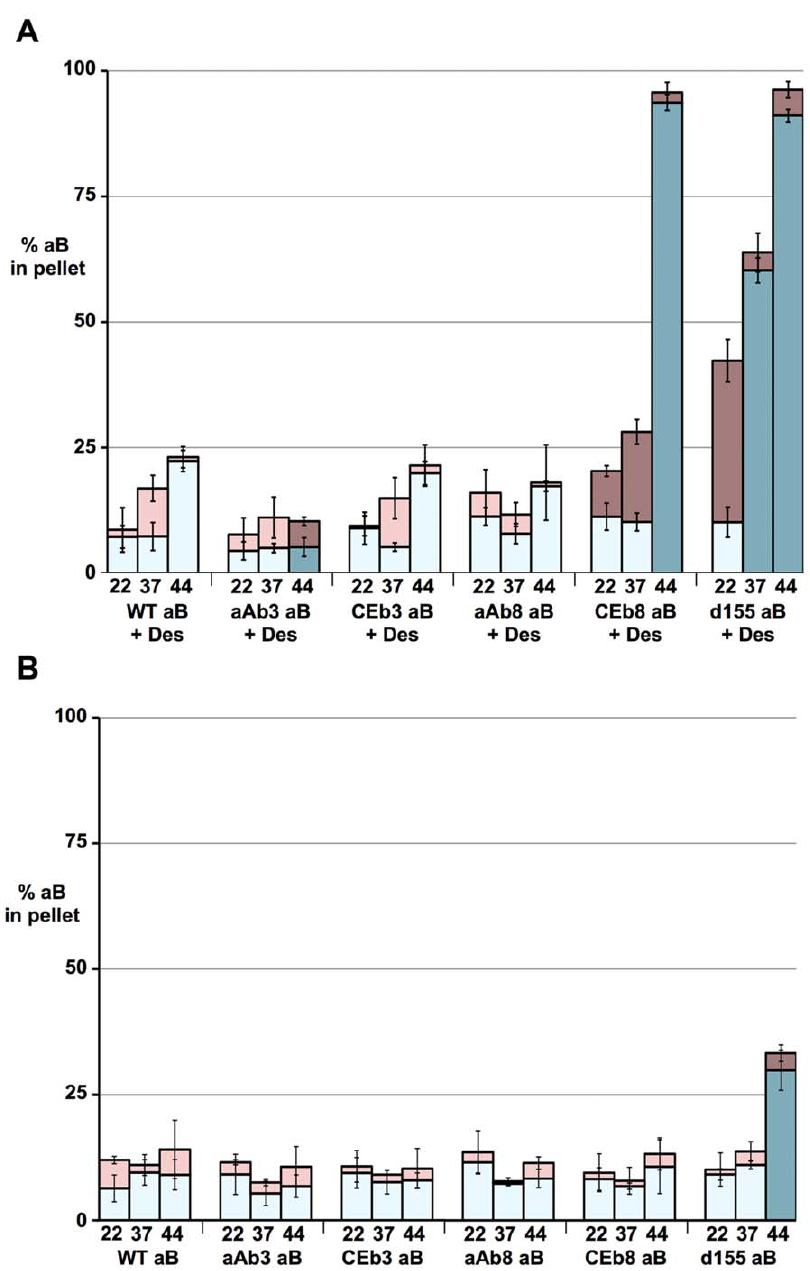
Figure 7. Cosedimentation of a B-crystallin with and without desmin filaments. A. Cosedimentation of a B-crystallin with desmin filaments. Summary of the low-speed (light blue and dark blue) and high-speed (light red and dark red) sedimentation data for various a B-crystallin protein constructs coassembled with desmin, as quantified by gel densitometry. The percentage of a B-crystallin in the pellet fractions at 22 u , 37 u and 44 u C was determined after both low- and high-speed sedimentation to quantify the association of a B-crystallin with the sedimented desmin filaments. The most striking observation is that both the CE b 8 (CEb8 aB + Des) and D 155–165 (d155 aB + Des) a B-crystallin protein constructs showed significant increases in desmin binding at 44 u C as shown by the high speed assay (44 u C, dark red bars). Conversely, a A b 3 a B-crystallin (aAb3 aB + Des) showed significantly decreased association at 44 u C at high speed. The CE b 3 (CEb3 aB) and a A b 8 (aAb8 aB) protein constructs showed similar sedimentation properties to wild type a B-crystallin. B. Aggregation of wild type and mutant a B-crystallins as measured by low- and high- speed sedimentation. Summary of the low-speed (blue) and high-speed (red) sedimentation data for the various a B-crystallin protein constructs as quantified by gel densitometry. The percentage of a B-crystallin in the pellet fractions at 22 u , 37 u and 44 u C was determined after both low- and high- speed sedimentation assay to quantify the aggregation of the a B-crystallins. All the other protein constructs showed similar sedimentation properties to the wild type (WT aB) a B-crystallin, except D 155–165 (d155 aB) a B-crystallin at 44 u C, which showed increased aggregation by both low- (darker blue) and high-speed (darker red) sedimentation assay.